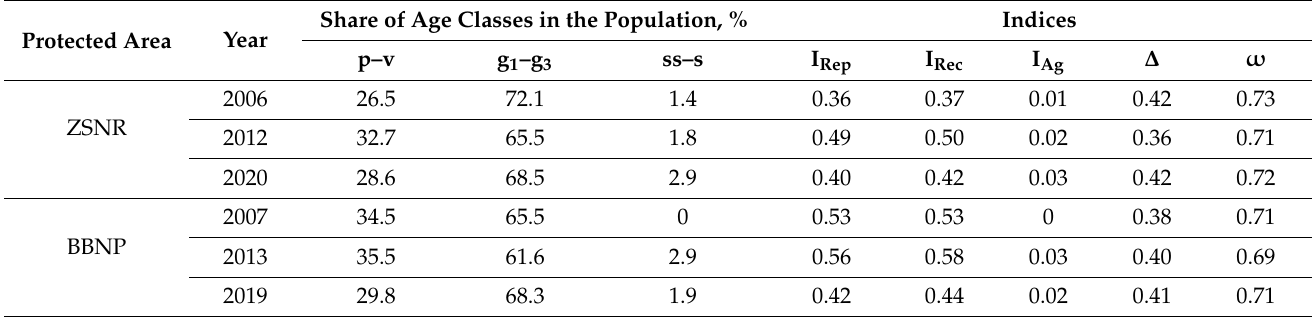
Table 1. Age structure of populations of P. chlorantha at the southern range margin (ZSNR—the Zhiguli State Nature Reserve, BBNP—the Busuluksky Bor National Park): p–v—pre-generative plants; g1–g3—generative plants; ss–s—sub-senile and senile